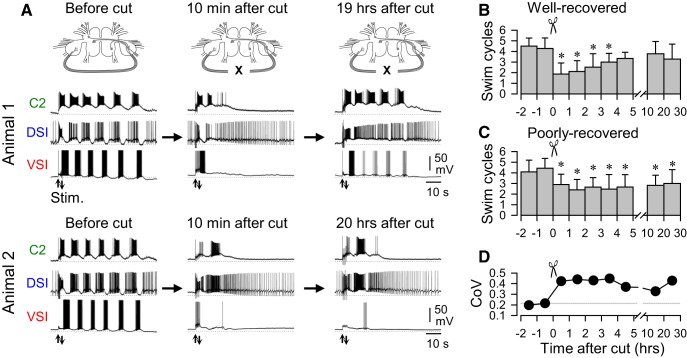
Individuals differed in the extent of motor pattern recovery after disconnection of PdN6. A, Simultaneous intracellular recordings from C2, DSI, and VSI from two representative animals (animals 1 and 2). PdN6 was transected as indicated by inset drawings above the traces. The stimulus was delivered to the left PdN3 to trigger the swim motor pattern. Arrows (Stim) indicate the time of PdN3 stimulation. The brains from both animals 1 and 2 showed a decrease in the number of VSI bursts after cutting PdN6 (from 6 to 1). The number of swim cycles recovered back to five bursts in the brain from animal 1 at 19 h after PdN6 cut, whereas it remained impaired in the brain from animal 2. A dotted line on each trace indicates −50 mV membrane potential. B, Bar graph showing averages of the swim cycles binned at 1 h intervals after PdN6 transection from well recovered preparations that exhibited ≥25% recovery in the number of swim cycles. Each bar shows the mean ± SD across preparations. Asterisks indicate significant difference from control (−1 to 0 h; p < 0.005 by one-way repeated-measures ANOVA with Holm–Sidak method). C, Bar graph showing averages of the swim cycles at binned at 1 h intervals after PdN6 disconnection from poorly recovered preparations that showed <25% recovery in the number of swim cycles. Asterisks indicate significant difference from control (−1 to 0 h; p < 0.001 by one-way repeated-measures ANOVA with Holm–Sidak method). D, The CoV of the number of bursts increased after PdN6 disconnection for all preparations.